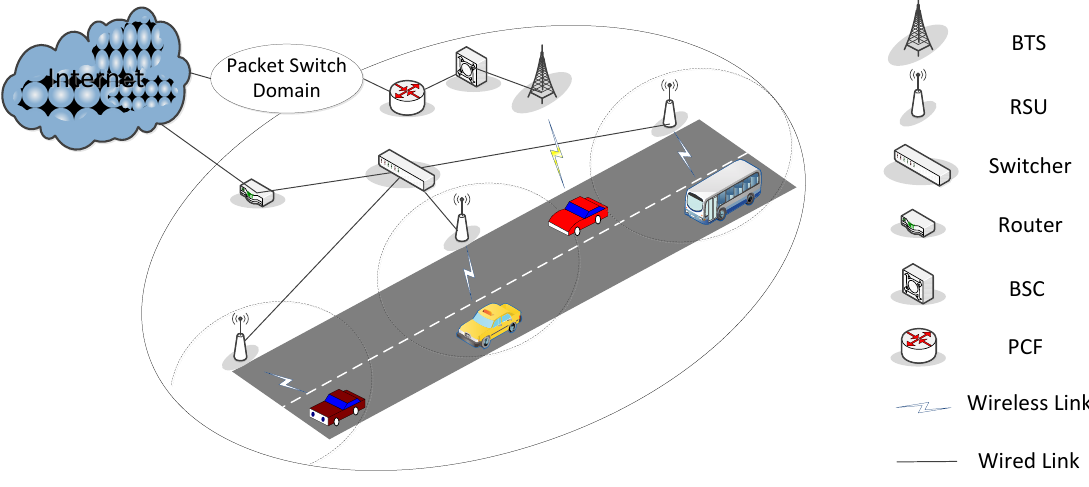
Figure 1. The reference scenario for the vehicular heterogeneous wireless